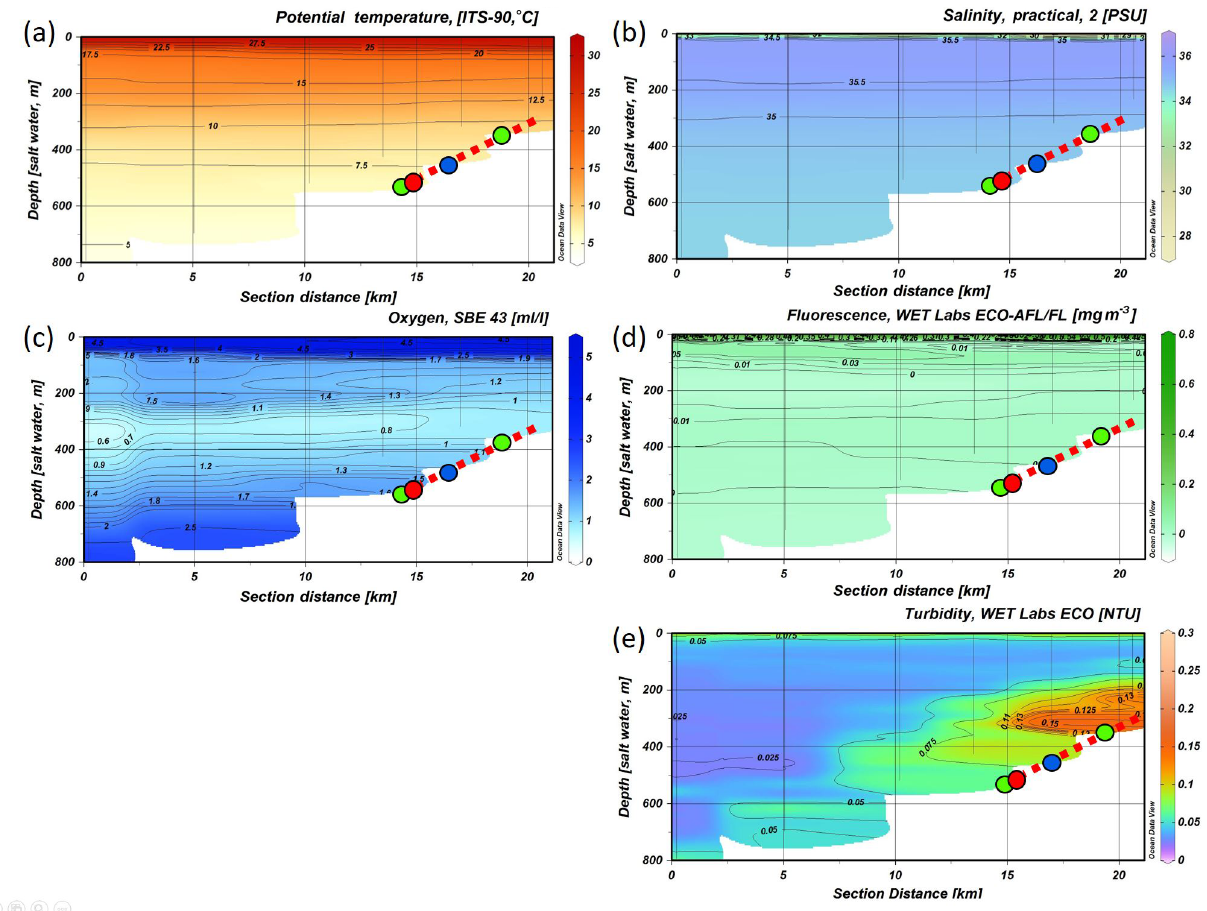
Figure 5. CTD transect across the Angolan margin. Shown are data for (a) potential temperature ( ◦ C), (b) salinity (PSU), (c) dissolved oxygen concentration (mLL − 1 ), (d) fluorescence (mgm − 3 ), (e) turbidity (NTU) (data plotted using Ocean Data View v.4.7.8; http://odv.awi.de, last access: 12 February 2016; Schlitzer, 2011). The depth occurrence of CWC mounds is marked by a red, dashed line, and the lander deployments are indicated by colored